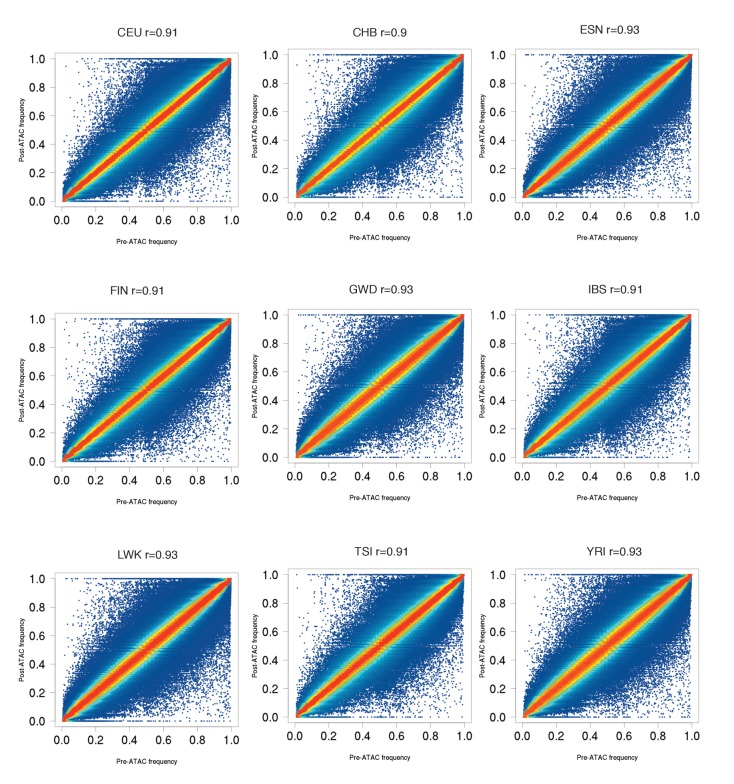
Pre-ATAC vs post-ATAC reference allele frequencies for nine populations, similar to ASW plot in Figure 1A.Most SNPs fall close to the diagonal, as expected if most SNPs are not caQTLs. All populations have 0.90 < r < 0.94.